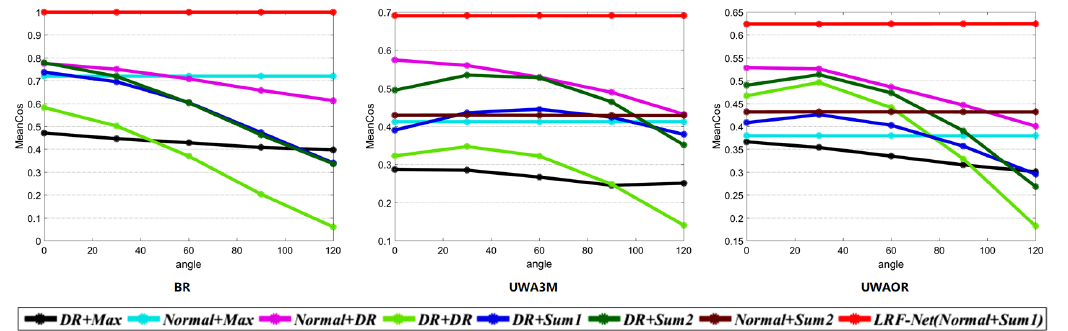
Figure 11. Robustness performance of eight combination on three rotated